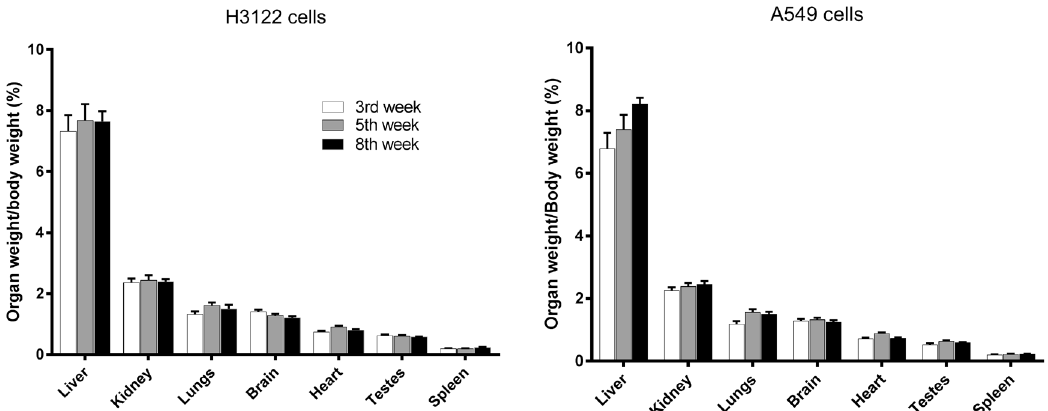
Figure 2. Organ weights of SCID mice injected with A549 or H3122 human lung adenocarcinoma cells via the tail vein at 3, 5, and 8 weeks after injection. Bar heights are means and error bars are SEM (n=4).